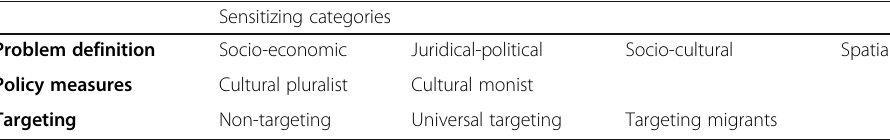
Table 1 Conceptual framework Sensitizing